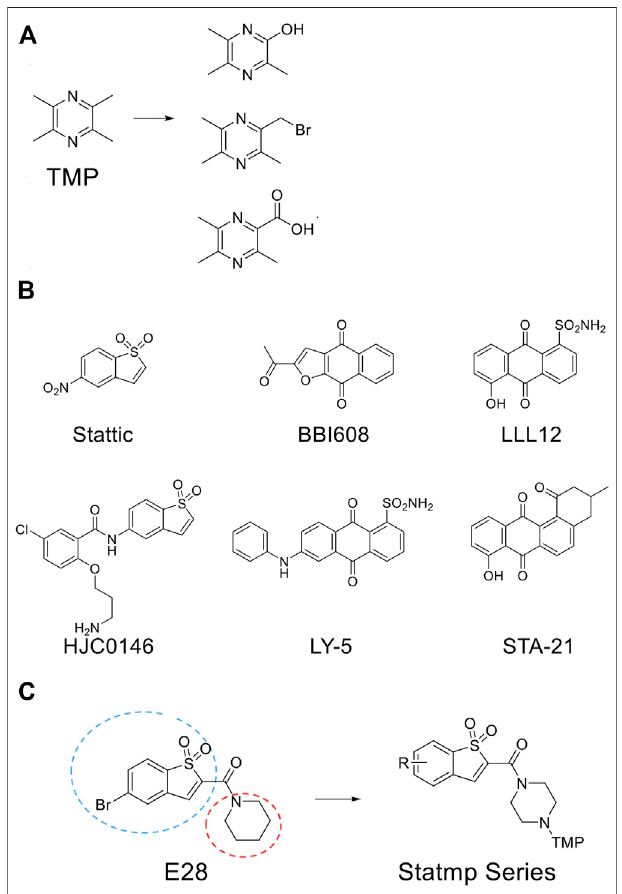
FIGURE 1 | The chemical structure involved in this study. (A) Three common fragments of TMP derivatives. (B) Some current reported Stat3 inhibitors. (C) From E28 to Statmp series which was via rational drug design and virtual screening.